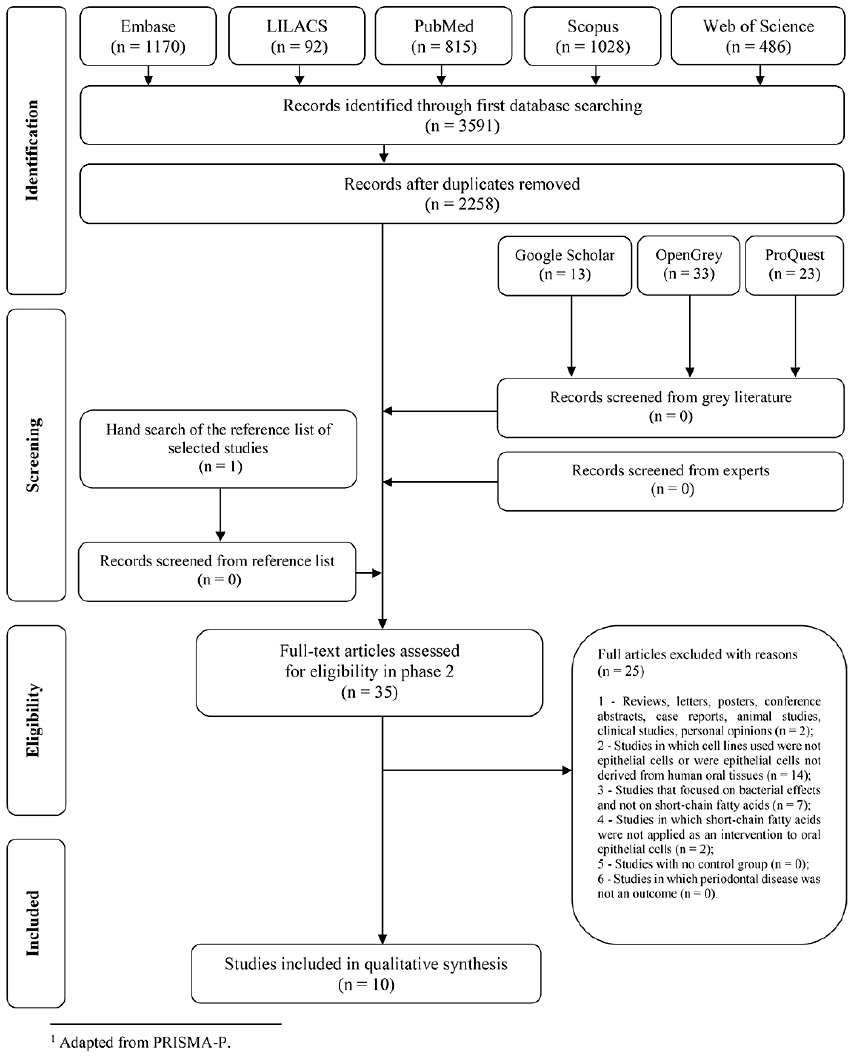
Figure 1. Flow Diagram of literature search and selection criteria.